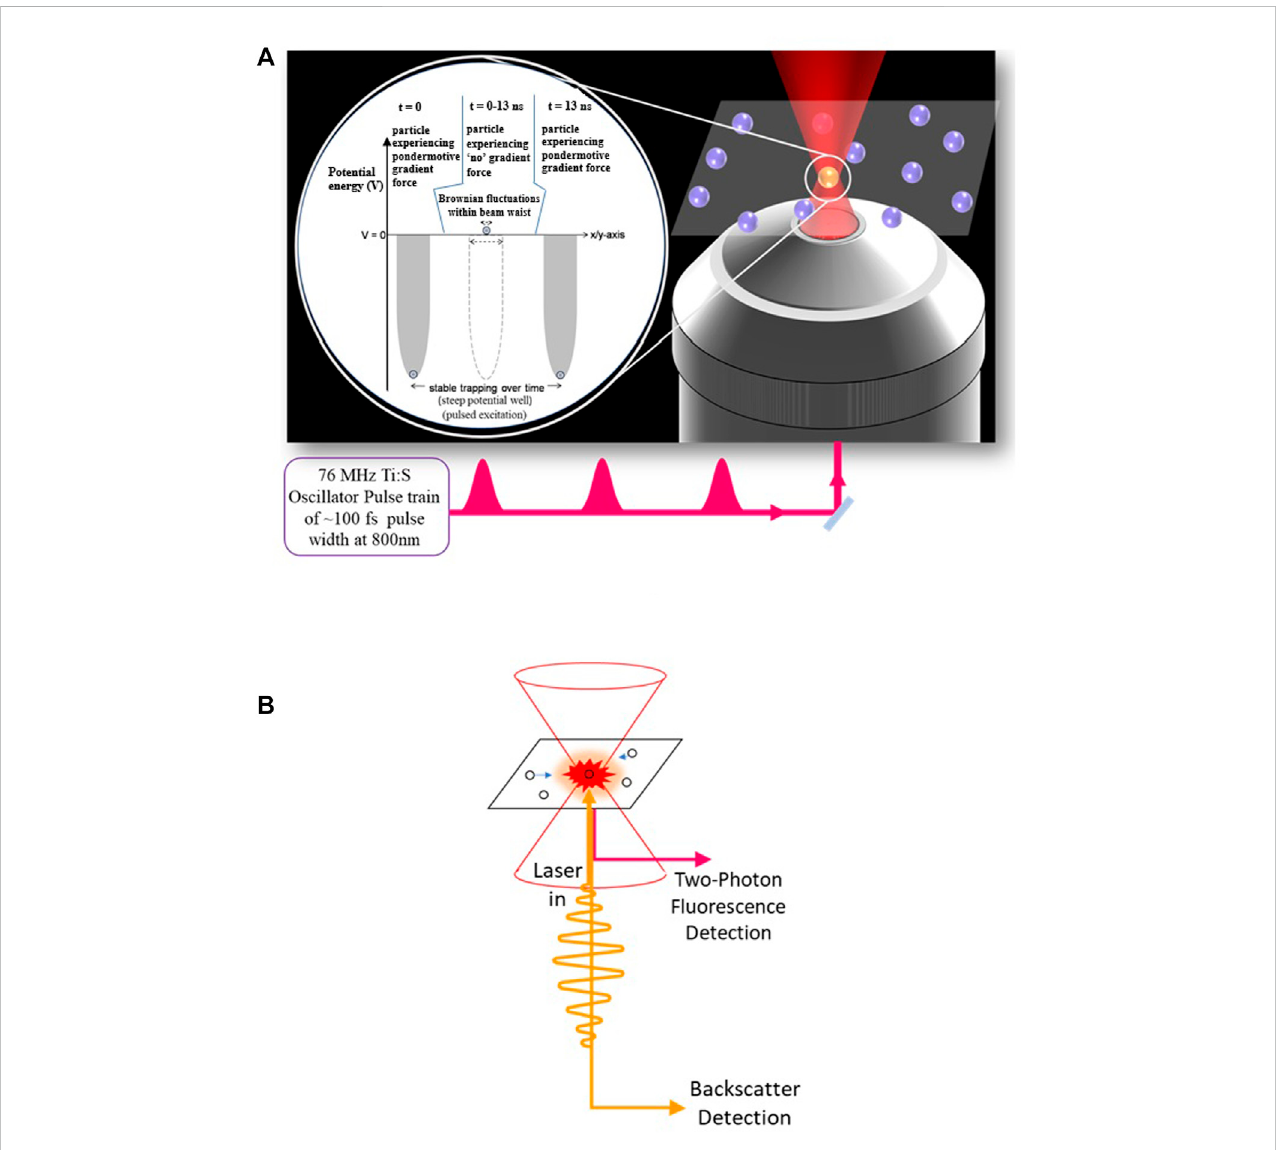
FIGURE 3 (A) Schematic diagram oftheFemtosecond pulsed optical tweezers(FOT) and (B) itsenhanced detection scheme due to theTwo-PhotonFluorescence (TPF)